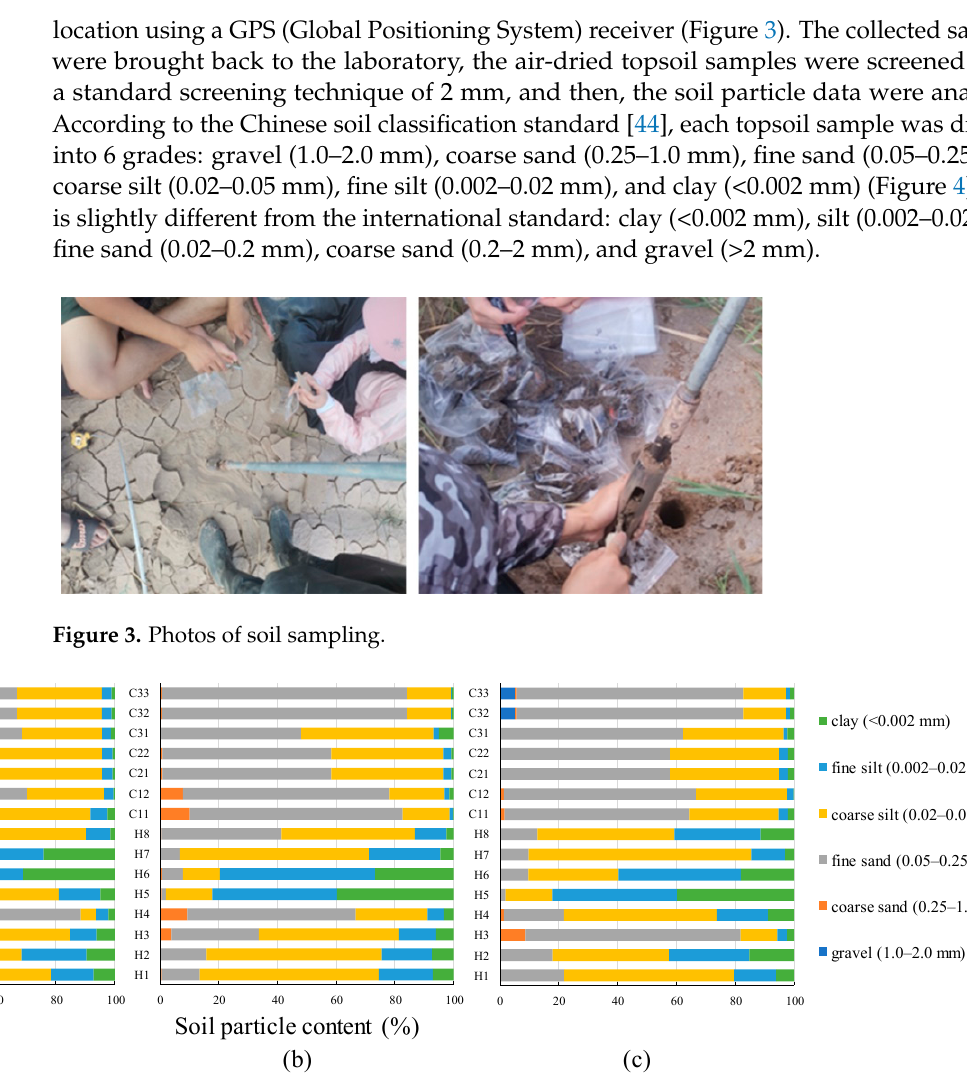
Figure 4. Histogram of soil particle-size distribution at sampling points with different soil layer thicknesses: ( a ) 0 ‒ 20 cm, ( b ) 20 ‒ 40 cm, and ( c ) 40 ‒ 60 cm.